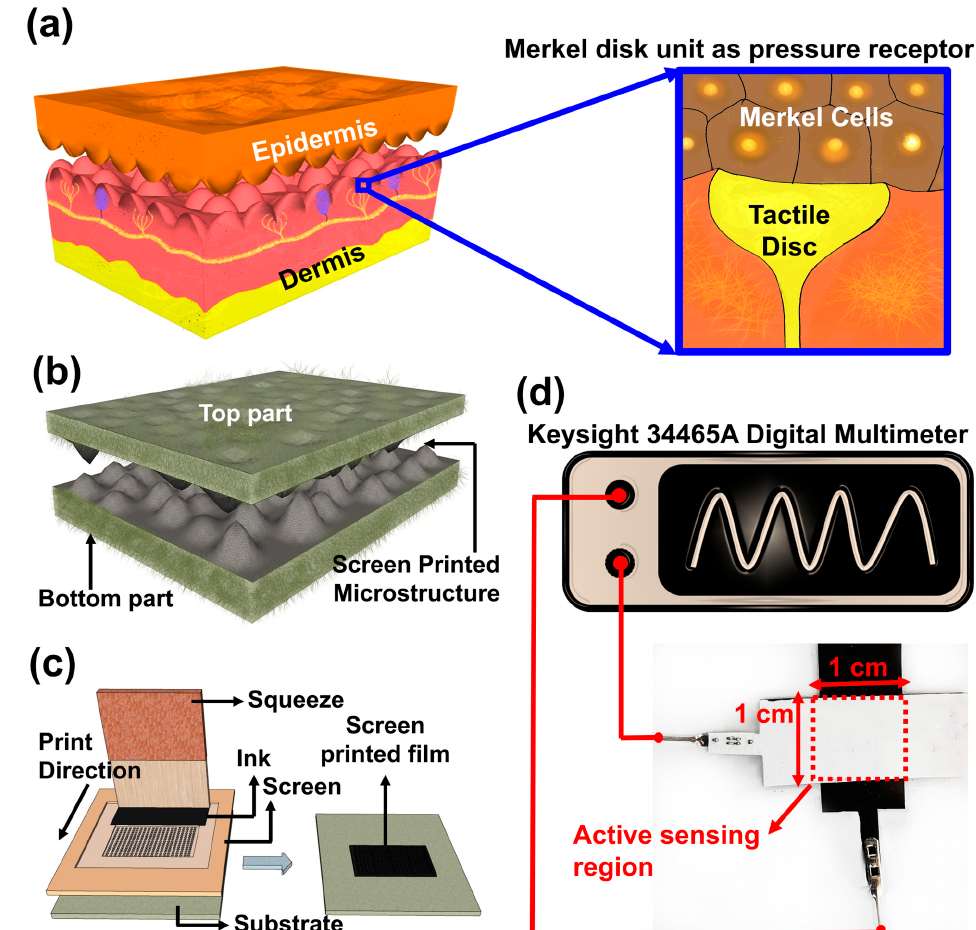
Figure 1. ( a ) Illustration of the biological microscale structures of the human epidermis; the underly- ing spinosum of the epidermis layer is a crucial element for high sensitivity. To respond to tactile stimulation, there are primary pressure receptors, called Merkel disc, at the tip around the microstruc- tures ( b ) our tactile sensor had a top and a bottom substrate; they were assembled face-to-face, with screen-printed microstructure in between at the interface ( c ) schematic diagram of screen printing method ( d ) optical image of the fabricated tactile sensor along with the schematic diagram of the measurement process. The fabricated sensor had an active sensing area of 1 × 1 cm 2 , where the pressure was applied.